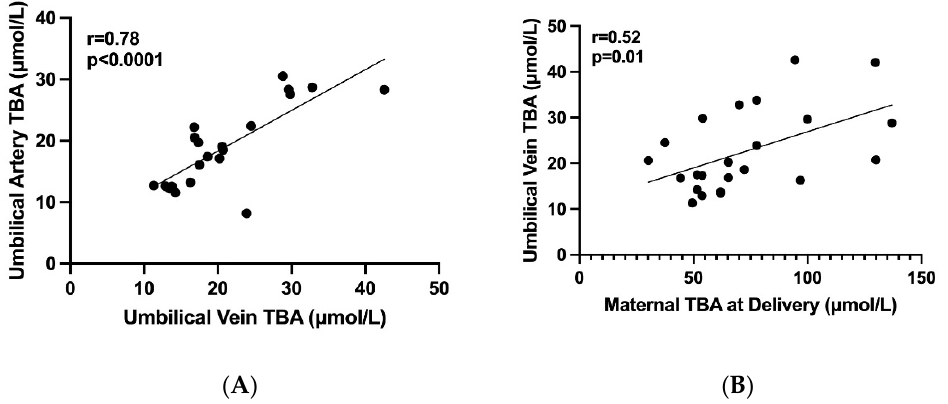
Figure 1. The total bile acids levels in maternal serum delivery, umbilical vein, and umbilical artery. The TBA level in maternal serum at delivery (black) compared to TBA levels in umbilical vein (gray, 23 samples) and umbilical artery (dotted, 19 samples). TBA—total bile acids in μ mol/L.